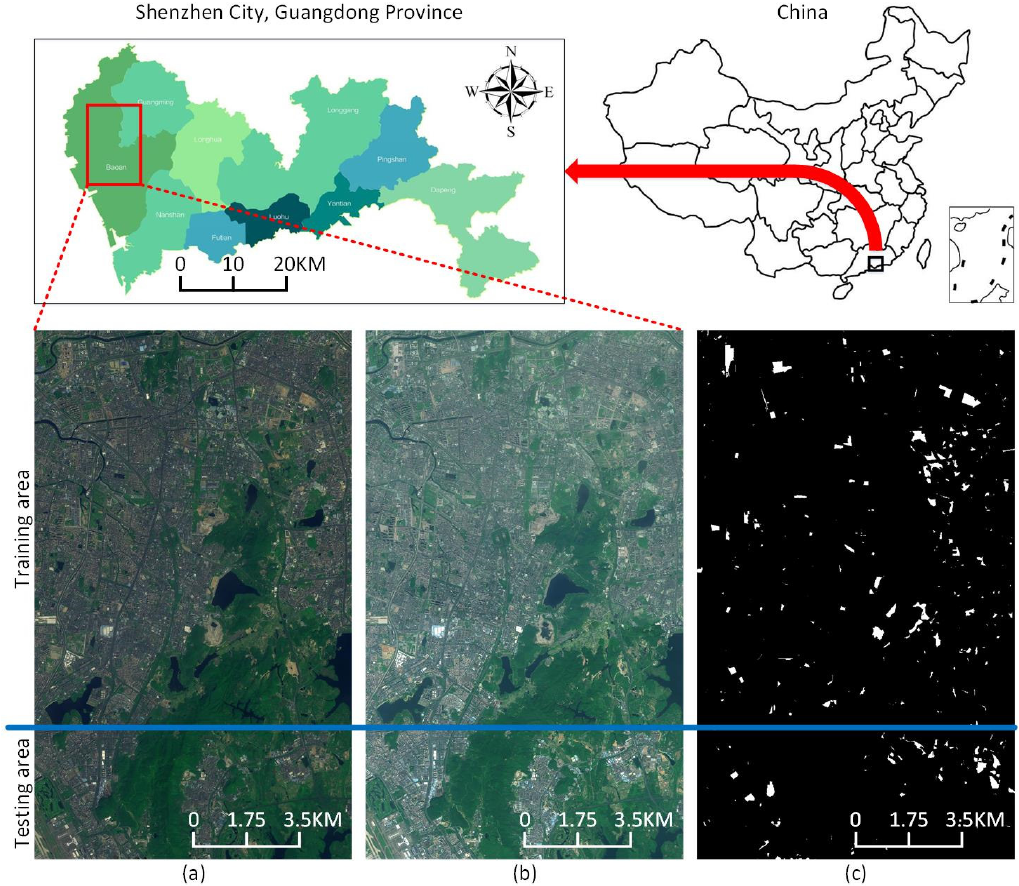
Figure 6. The overview of Shenzhen dataset and the corresponding change map reference: ( a ) image acquired at time T 1 , ( b ) image acquired at time T 2 , ( c ) reference map.